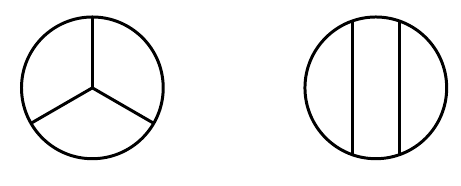
Figure 2 . The skeletons graphs at three-loop order. The tetrahedral graph on the left starts contributing at order r 6 R 4 in the derivative expansion whereas the ladder diagram on the right has its (cid:12)rst contribution at order r 8 R 4